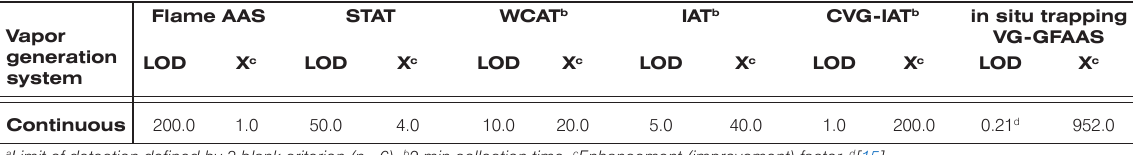
Table 3. Comparison of limits of detection (LOD) a for nickel using various atom traps (ng mL -1 ).